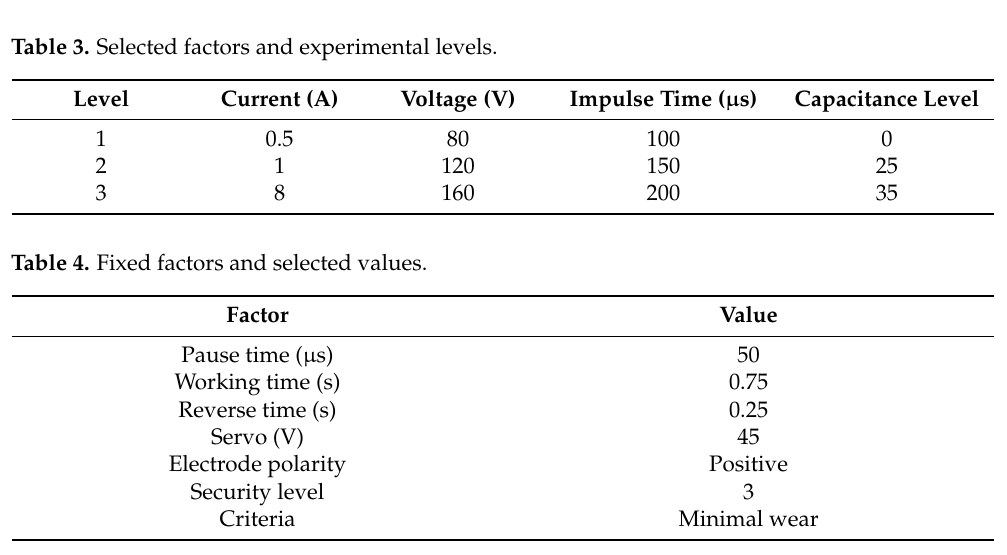
Table 4. Fixed factors and selected values.